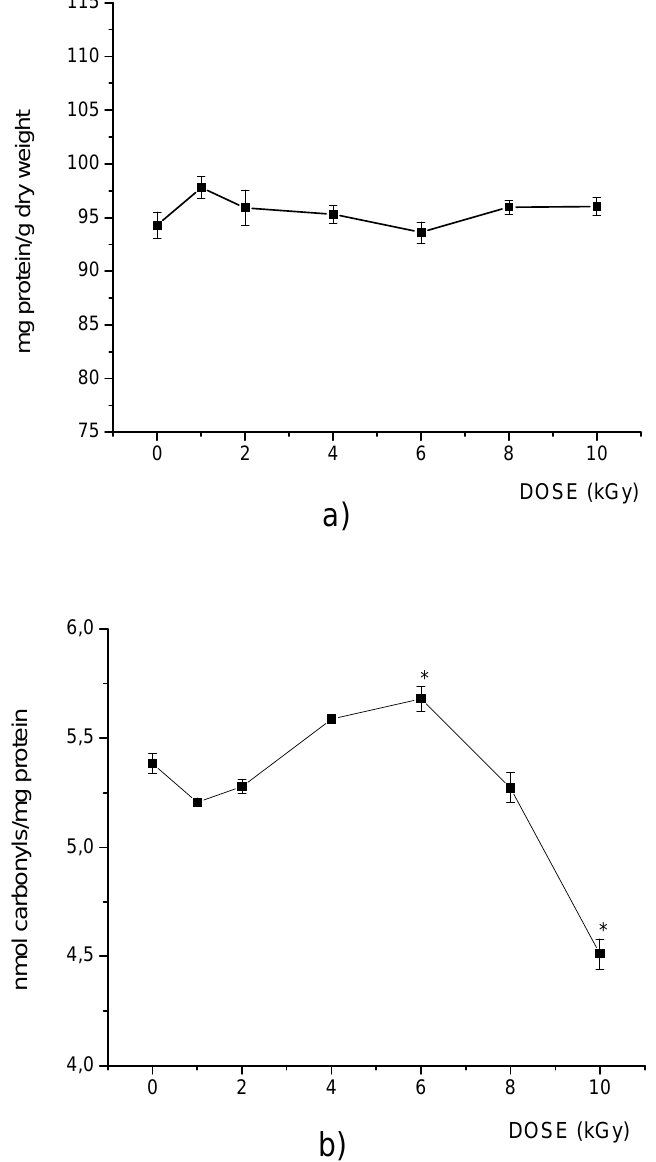
Figure 2 . Effects γ -irradiation on soluble protein content (a) and protein oxidation intensity (b)